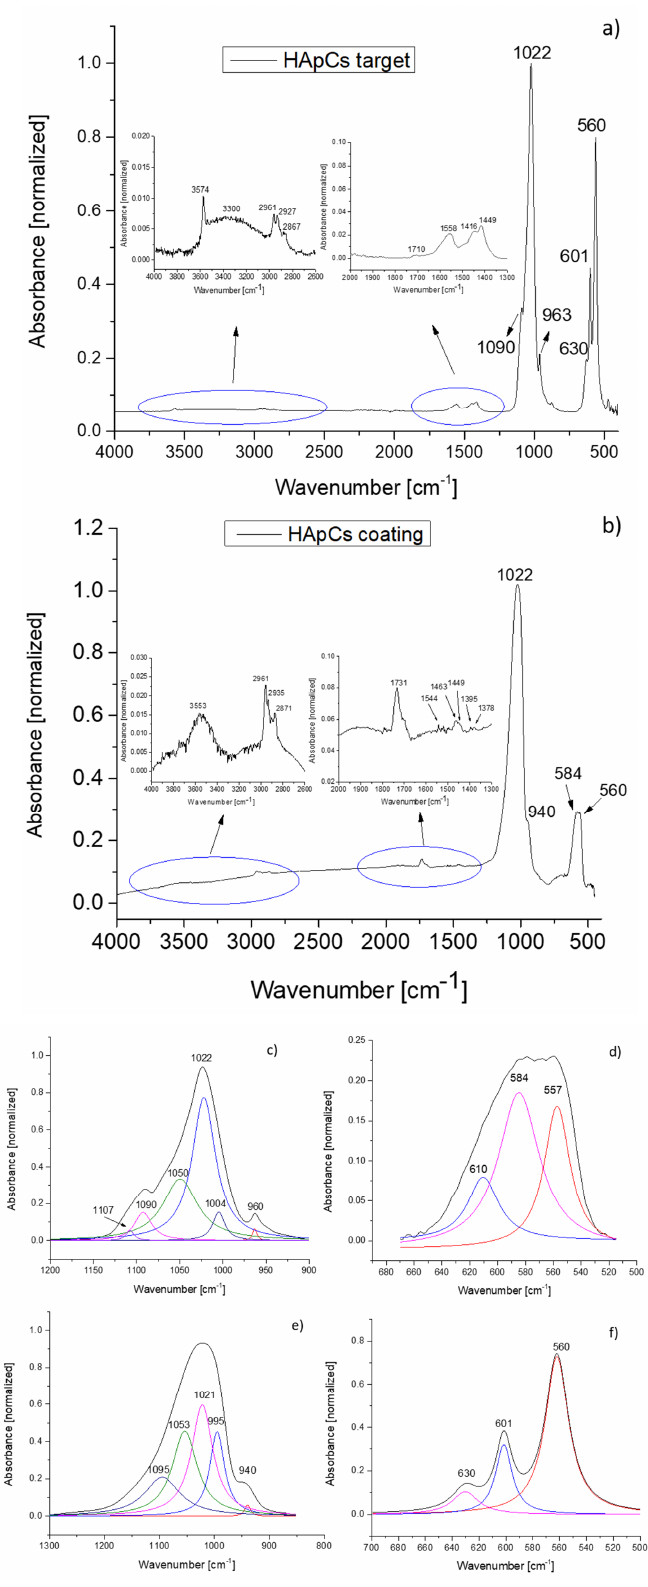
Figure 4. FTIR spectra of: ( a ) HApCs target; ( b ) HApCs coating deposited on Si substrate at 5 × 10 -3 mbarr Ar gas working pressure; FTIR deconvoluted spectra of HApCs target and of HApCs coating deposited on Si substrate at 5 × 10 -3 mbarr Ar gas working pressure in: ( c , e ) 1200–850 cm - 1 range; ( d , f ) 680–500 cm -1 range. In the 4000–2600 cm −1 domain, there are shifts of the IR bands which correspond to amine and hydroxyl groups (see Figure 4b), as an indication of the interaction between the NH 3 groups of chitosan with the OH groups of HAp during the plasma deposition process. The characteristic IR bands of N-H vibrations from 3574 cm −1 and O-H vibrations from 3300 cm −1 (Figure 4a) overlap and appear as one broad band centered at 3553 cm −1 in the spectrum of the film (Figure 4b). The IR bands at 2927 cm −1 (C-H asymmetric stretching in CH 2 ) and 2867 cm −1 (C-H symmetric stretching in CH 3 ) in the IR spectrum of the target are shifted to 2935 and 2871 cm −1 in the spectrum of the film, while the position of the IR band from 2961 cm −1 (C-H asymmetric stretching in CH 3 ) remains unchanged. In the 1800–1300 cm −1 spectral range, the IR band from 1710 cm −1 characteristic of C=O vibrations [32,33] in the IR spectrum of the HApCs target (see Figure 4a) is shifted to 1744 cm −1 in the spectrum of the film (Figure 4b). Further, the IR band characteristic of N-H vibrations [5] from 1558 cm −1 (Figure 4a b) is shifted to 1544 cm −1 (Figure 4b). The IR bands from ~ 1400 cm −1 due to [CO 3 ] 2− groups [10] present in the target are strongly diminished in the film. The IR bands from 1395 and 1378 cm −1 are due to C-H vibrations in the chitosan structure. The IR bands characteristic of P-O vibrational modes are broadened in the spectrum of the film in comparison with the spectrum of the target (Figure 4a,b). Therefore, peak fitting analysis is recommended to be performed for a proper identification of the molecular structure of HApCs layers. The deconvolution of the IR molecular band positioned at around 1000 cm −1 in the HApCs coating revealed slight shifts from 1090, 1022 and 960 (in the deconvoluted IR spectrum of the target, Figures 4c) to 1095, 1022 and 940 cm −1 (in the deconvoluted IR spectrum of the film, Figure 4e). These